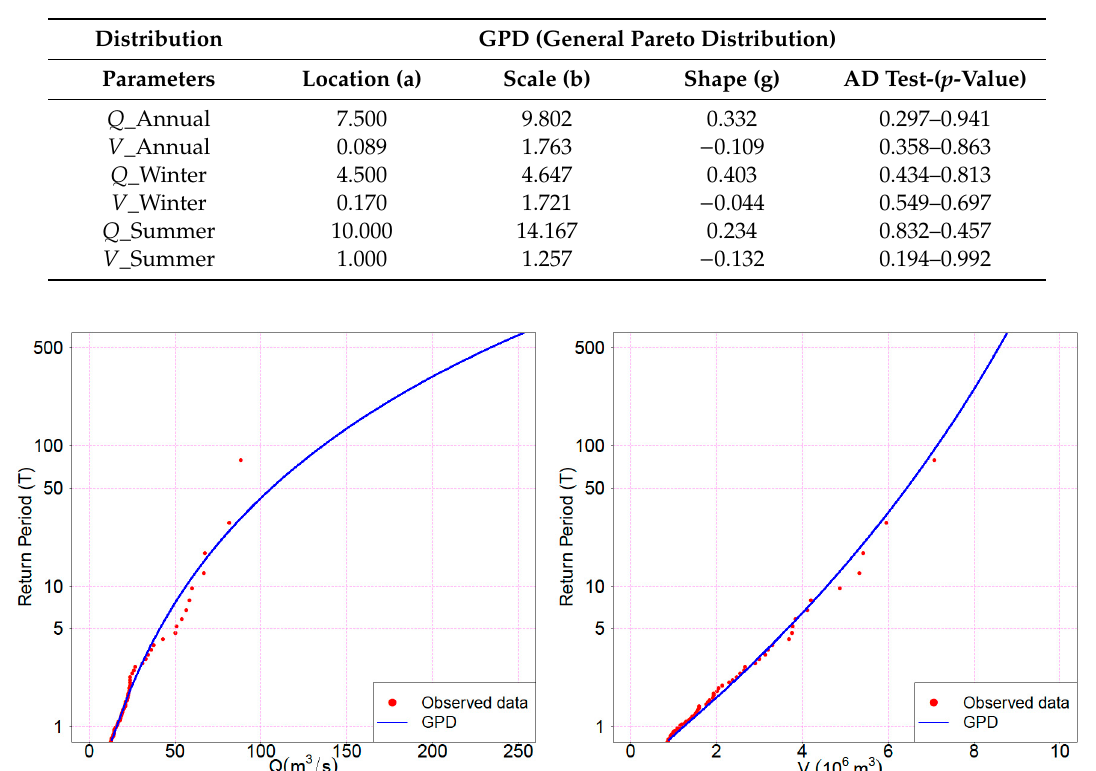
Table 5. Probability-weighted moments (PWM) estimated parameters.